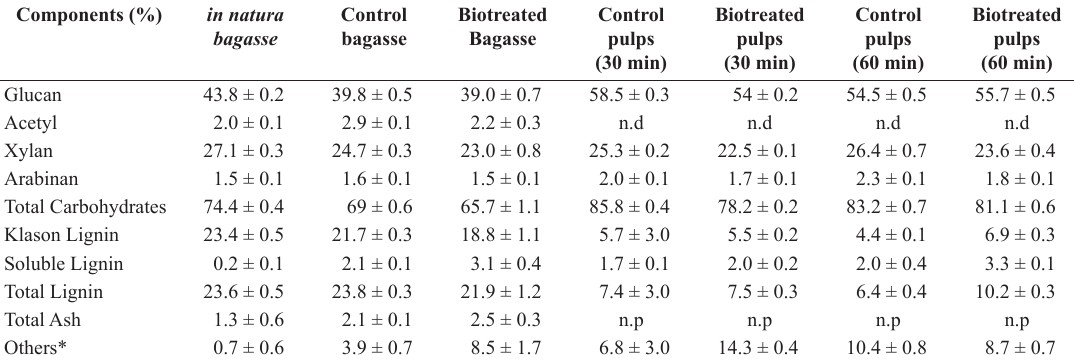
Table 1. Chemical composition of decayed (biotreated) and undecayed (control) bagasses as well as their respective NaOH/AQ pulps (30 and 60 min) incubated for 30 days with C. subvermispora and compared with in natura bagasse. Components